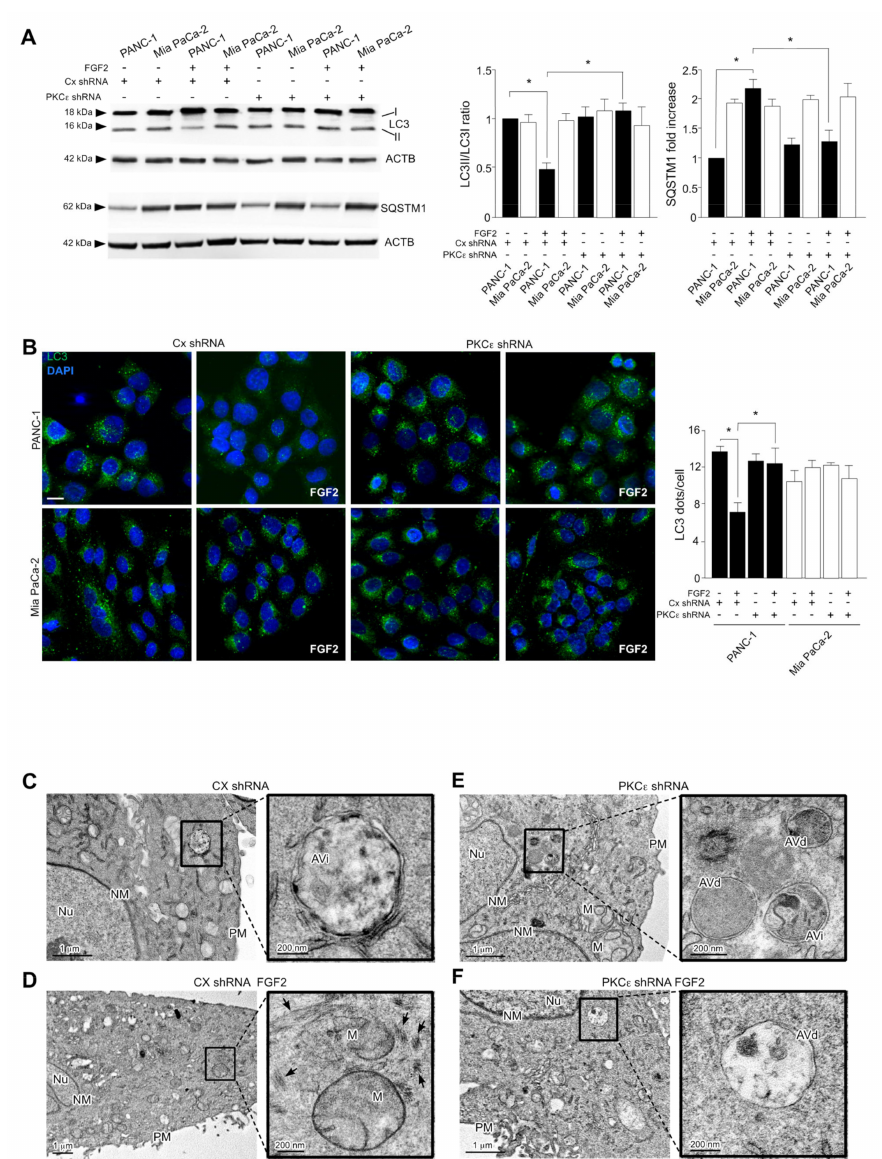
Figure 5. PKC ε depletion also negatively impacts on FGF2 − dependent inhibition of autophagy. PANC − 1 and MiaPaCa − 2 cells stably transduced with PKC ε shRNA or with an unrelated shRNA were left untreated or stimulated with FGF2 as above. ( A ) Western blot analysis shows that PKC ε knockdown abolishes the decrease of the autophagic marker LC3 − II, as well as the increase of the autophagic substrate SQSTM1, induced by FGF2 stimulation exclusively in PANC − 1 cells. Equal loading was assessed with the anti-actin antibody. Results are expressed as mean value ± SD ( n = 3). The densitometric analysis was performed as reported above. ANOVA with Tukey’s multiple comparison test: * p ≤ 0.05. ( B ) Quantitative immunofluorescence analysis shows that the reduction of LC3 positive dots per cell, evident only in PANC − 1 upon FGF2 is reversed by PKC ε depletion. Quantitative analysis was performed as described in Materials and Methods, and results are expressed as mean values ± SD ( n = 3). ANOVA with Tukey’s multiple comparison test: * p ≤ 0.05. ( C – F ) Ultrastructural analysis by transmission electron microscopy (TEM) shows initial autophagic vacuoles (AVi) with double isolation membrane in the cytoplasm of unstimulated PANC − 1 Cx shRNA cells ( C , magnification box). The examination of PANC − 1 Cx shRNA stimulated with FGF2 shows a spindle − like shape, a reduced presence of AVs compared to unstimulated cells, and a higher cytoplasmatic complexity, with several intracellular filaments ( D ), arrows in the magnification box, possibly corresponding to vimentin bundles ( D ). AVi and degradative (AVd) autophagic vacuoles in the cytoplasm of both unstimulated and FGF2 − stimulated PKC ε shRNA cells (see magnification boxes). AVi: Initial autophagic vacuole; AVd: degradative autophagic vacuole; M: mitochondrion; Nu: nucleus; NM: nuclear membrane; PM: plasma membrane. Bars: 1 µ m, 200 nm. Original blots see Figure